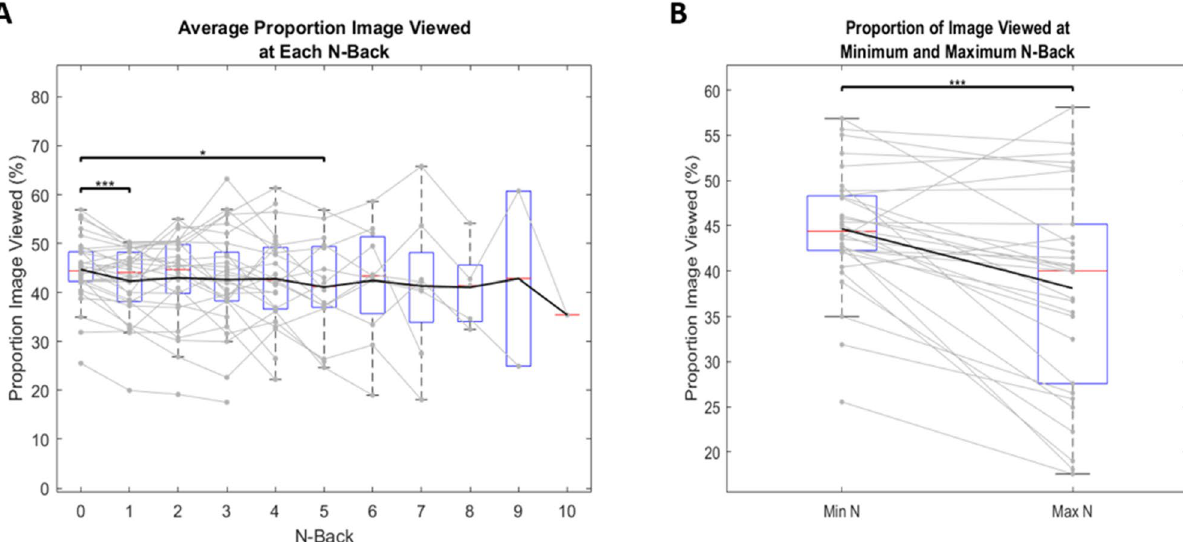
Figure 10. Proportion of image viewed. Black line represents mean values. Solid gray lines represent individual subjects. Red lines represent median values. Blue boxes represent the IQR where each lower bound signifies Q1 and each upper bound signifies Q3. Lower and upper bounds of grey dotted lines represent minimum and maximum values, respectively. Points that lie outside these bounds are considered outliers. One star represents a significance value of p < 0.05, two stars represents a significance value of p < 0.01, and three stars represents a significance value of p < 0.001. ( A ) Demonstrates average proportion of image viewed across each N-back. For clarity, only interactions against N = 0 are plotted here. ( B ) Demonstrates the average proportion of image viewed at each subject’s minimum N-back (N = 0 for all subjects), compared to their maximum N-back (variable across